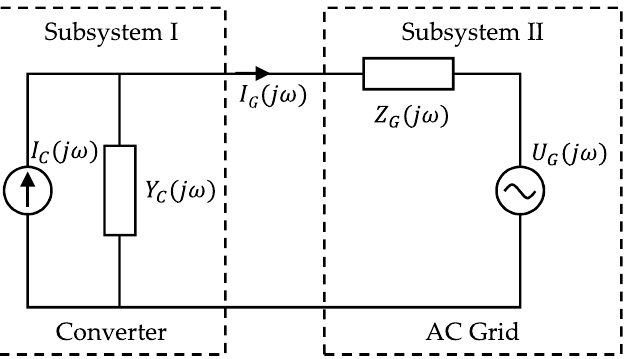
Figure 1. Equivalent circuit diagram of investigated